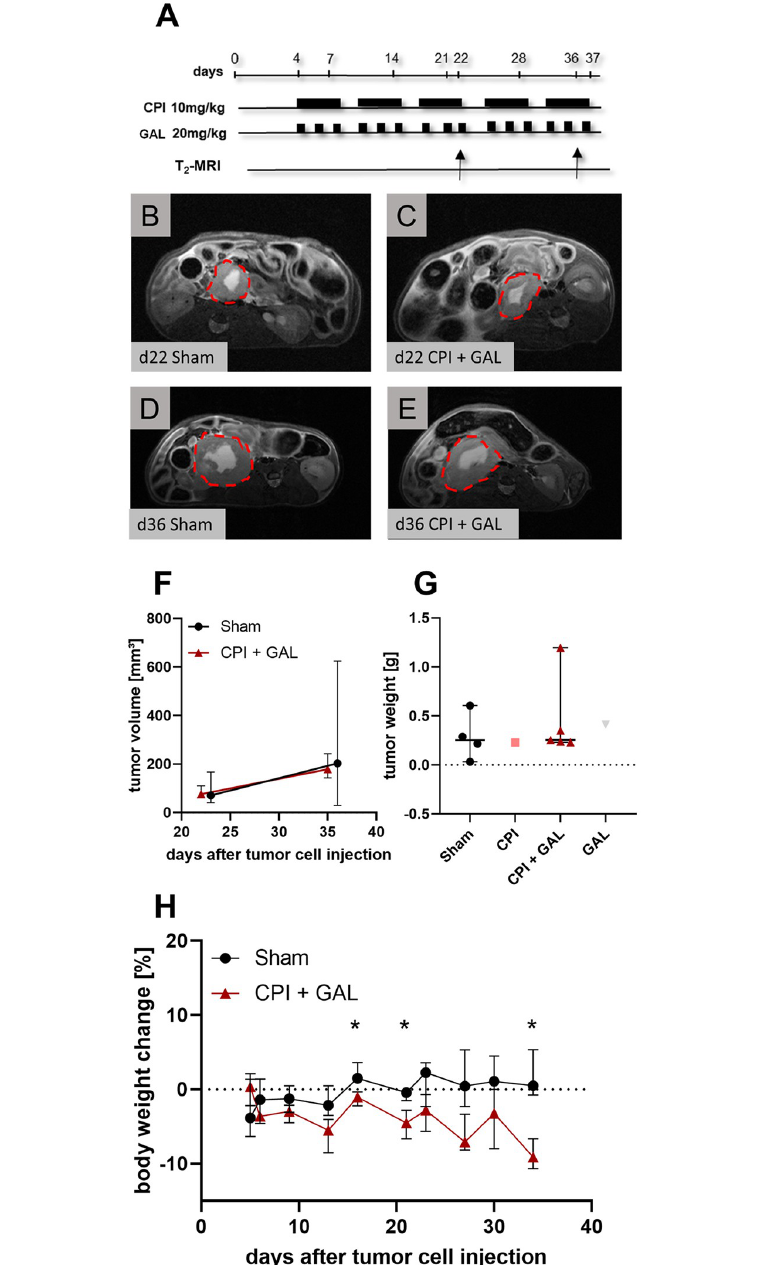
Fig 5. The combinatorial treatment of CPI-613 and galloflavin did not cause an impairment of the tumor growth in vivo . ( A ) To quantify the therapeutic effect in vivo , the 6606PDA cells were injected at day 0 into the pancreas of C57BL6/J mice. The treatment started after 4 days of recovery, CPI (10 mg/kg) was injected five times per week and galloflavin (GAL, 20 mg/kg) three times weekly. ( B-F ) The tumor of the combinatorial therapy and sham treated mice was identified by MRI on day 22 and 36 (tumors are framed by a red-dotted line) and the tumor volume was quantified at these time points. ( G ) The tumor weight of all treatment groups was measured at the end of the experiment on day 37. ( H ) The body weight change of sham and CPI + galloflavin treated mice was quantified at the indicated days. Biological replicates: F: n = 4 per group; G-H: Sham n = 4, CPI n = 1, CPI-GAL n = 5, GAL n = 1. � P < 0.05 was considered significant, calculated by Two-Way repeated measure ANOVA and correction of multi-comparison by Sidak’s